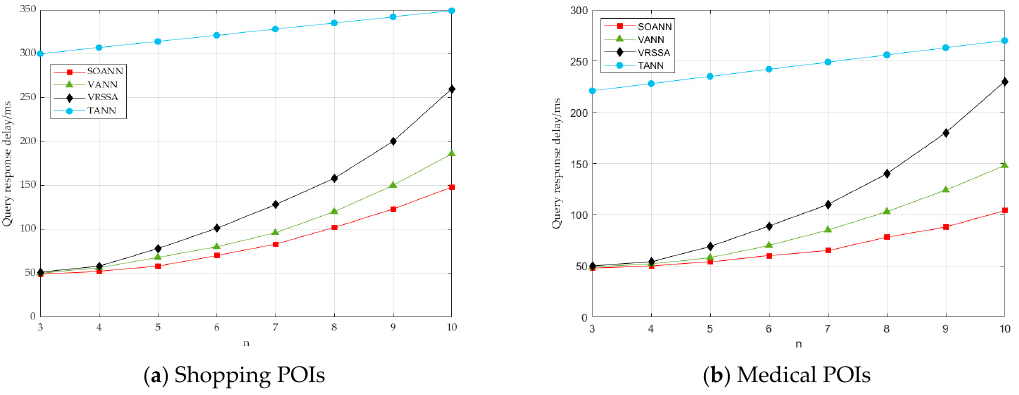
Figure 16. The effect of number of users on query response time. Figure 16. The e ff ect of number of users on query response